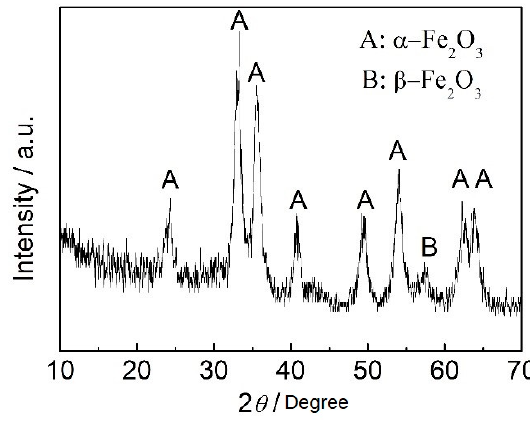
Figure 9. XRD pattern of the debris collected from the worn surface of B45 after wear testing under 75 N.